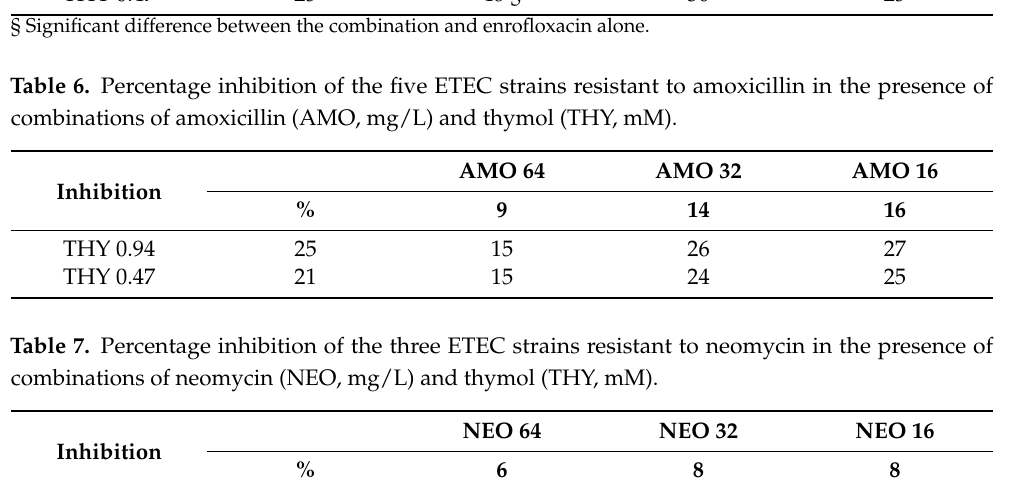
Table 5. Percentage inhibition of the three ETEC strains resistant to enrofloxacin in the presence of combinations of enrofloxacin (ENR, mg/L) and thymol (THY, mM). ENR 1 ENR 0.5 ENR 0.25 Inhibition % 53 24 17 THY 0.94 38 79 § 46 38 THY 0.47 25 48 § 30 25